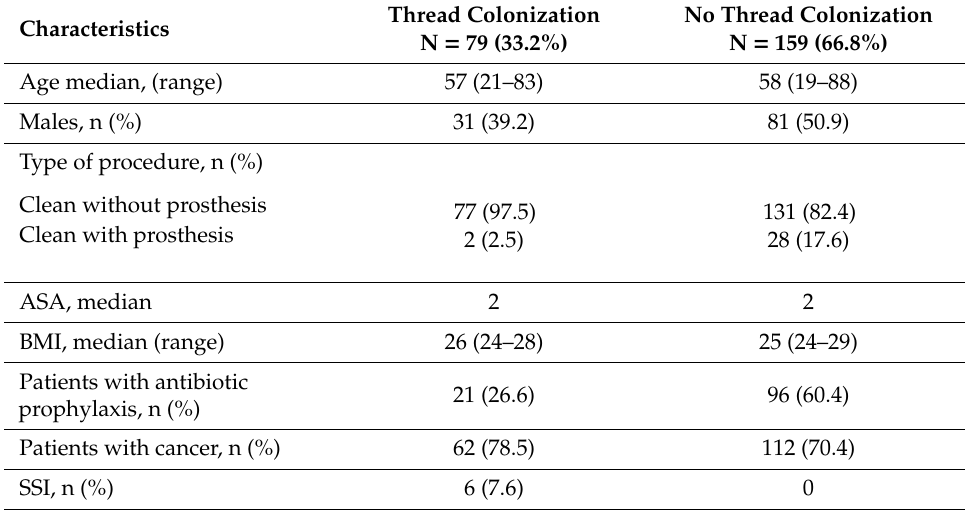
Table 2. Characteristics of the patients enrolled, according to the presence of thread